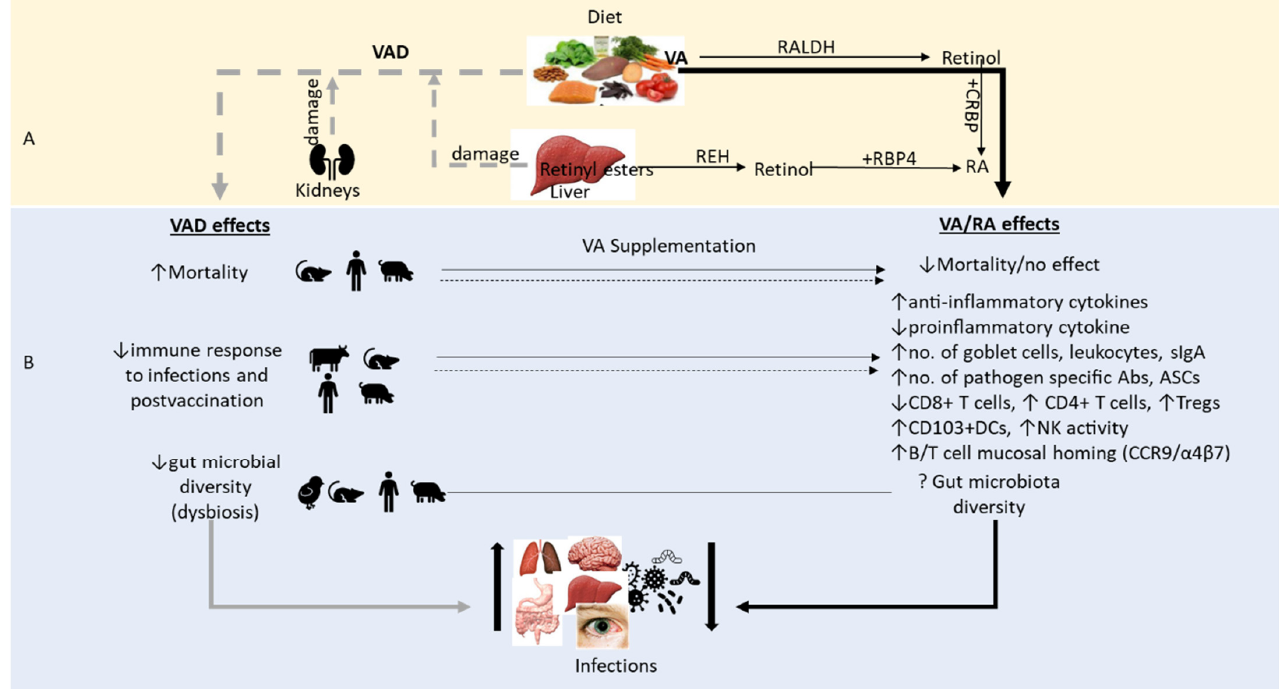
Figure 2. ( A ) Vitamin A (VA) metabolism and factors contributing to VA deficiency (VAD). ( B ) VA supplementation to VAD hosts reversed the negative impact of VAD on immune system and gut microbiota. Thin solid line with arrow—vitamin A supplementation (VAS) rescued effects of VAD; thin dotted line—VAS did not rescue the effects of VAD in clinical studies; thin solid line without arrow/?—VAS effects not known. RALDH, retinaldehyde dehydrogenase; REH, retinyl ester hydrolase; CRBP, cellular retinol-binding protein; ASCs, antibody secreting cells.